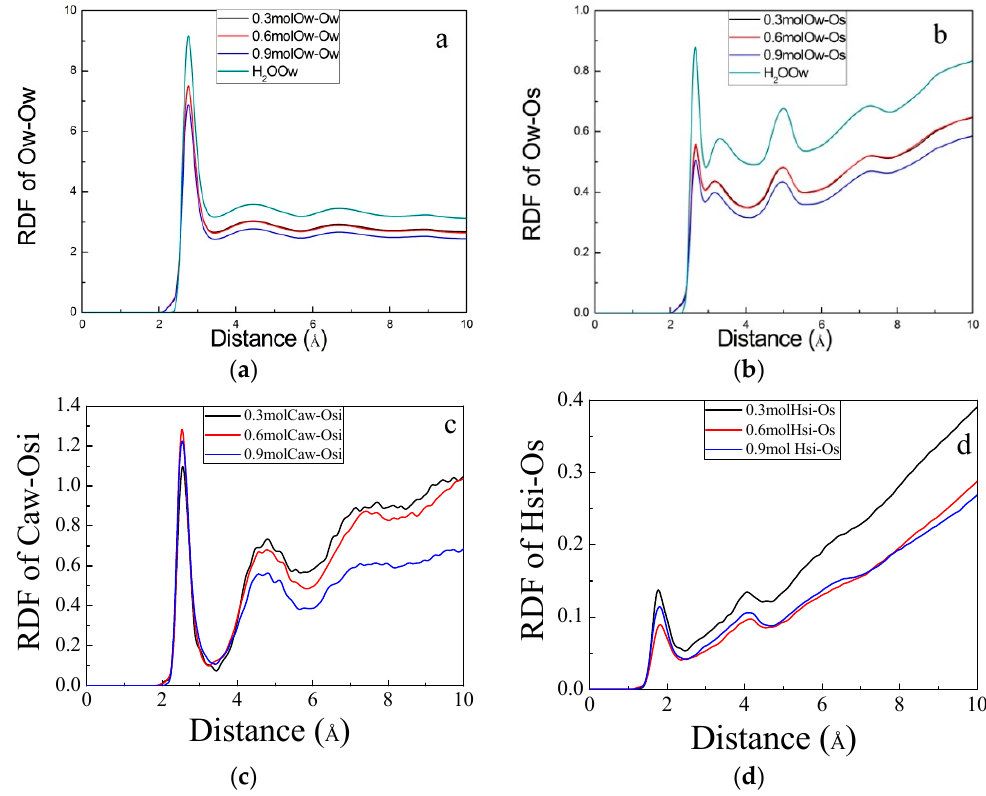
Figure 7. Radial distribution function (RDF) of ( a ) Ow (oxygen in water)–Ow, ( b ) Ow–Os (oxygen at the interface), ( c ) Caw (Ca at the gel channel interface)–Osi (oxygen in silanol), and ( d ) Hsi (hydrogen in the siloxane hydroxyl group)–Os.